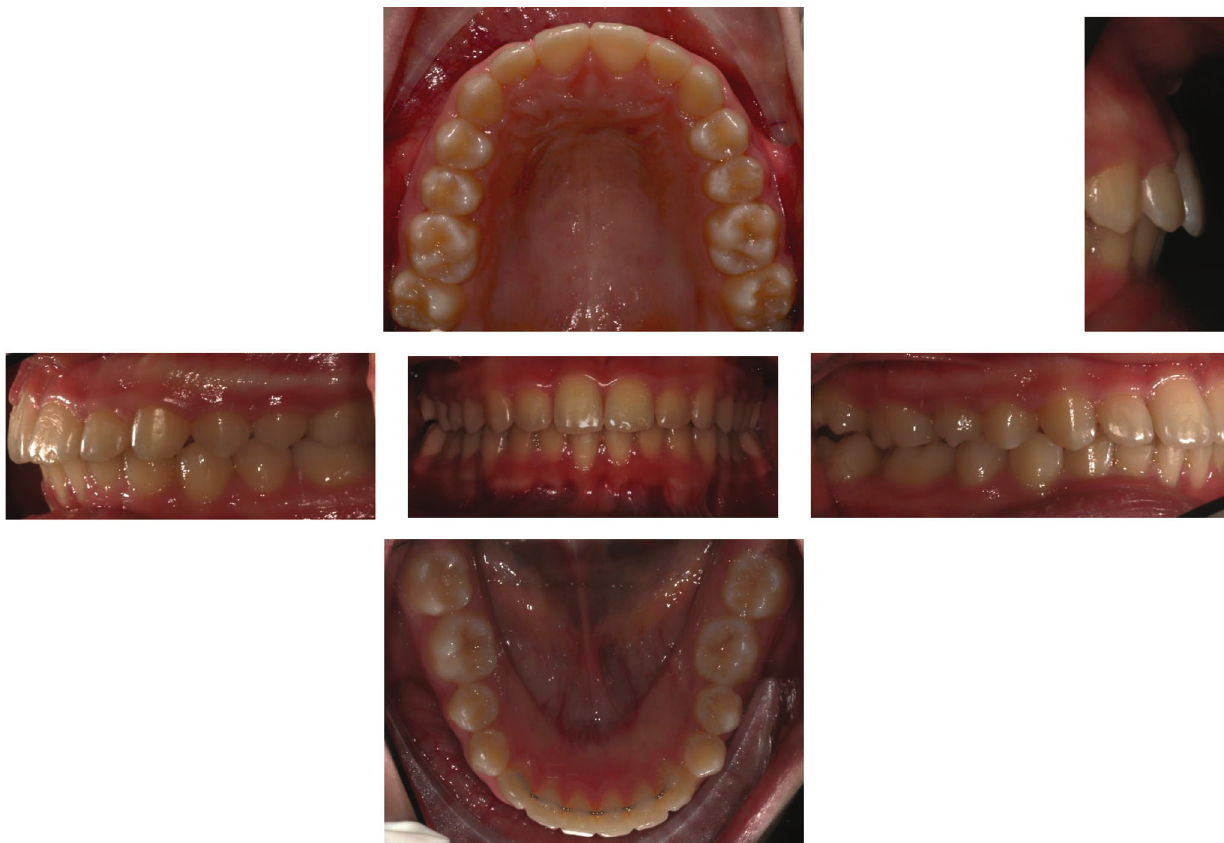
Figure 16: Final intraoral